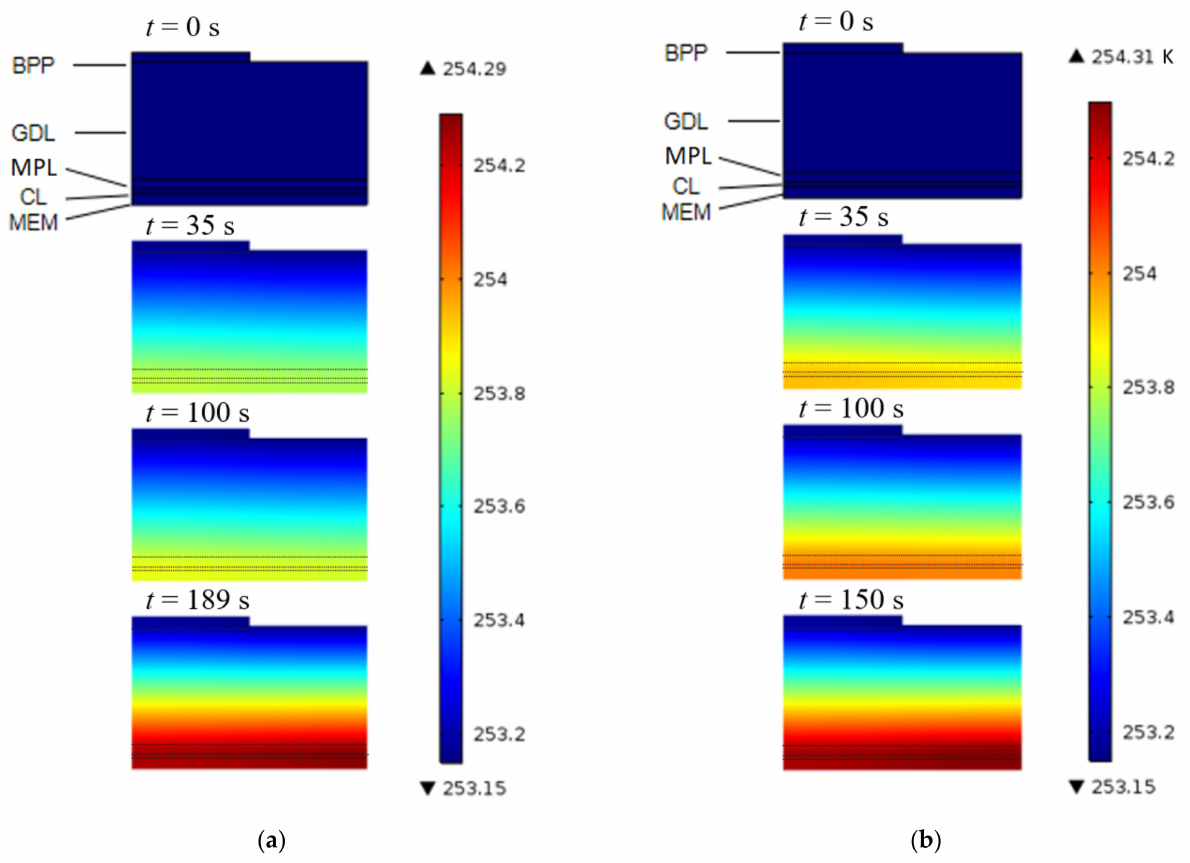
Figure 7. Distribution of the temperature in cathode when started from − 20 ◦ C at 0.08 A/cm 2 under ICK and TD. ( a ) under ICK; ( b ) under